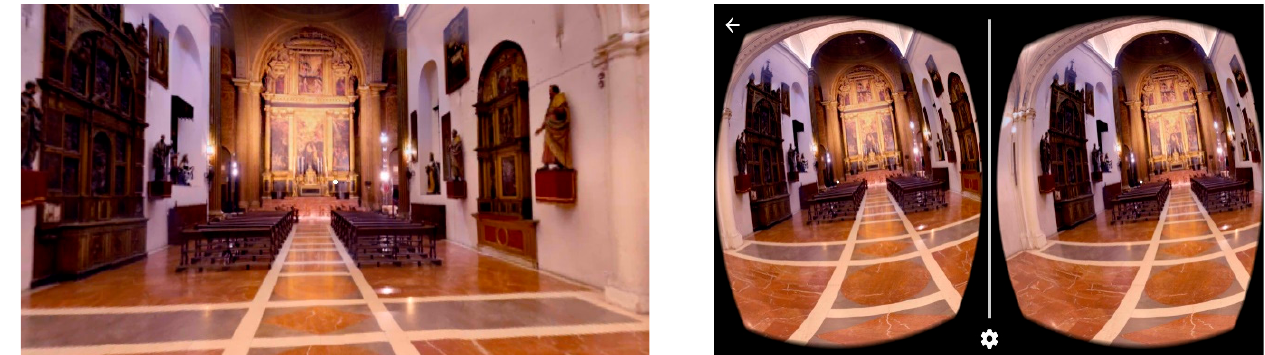
Figure 1. Images of the object produced to study art in the Church of the Annunciation in Seville. Source: developed by the authors.